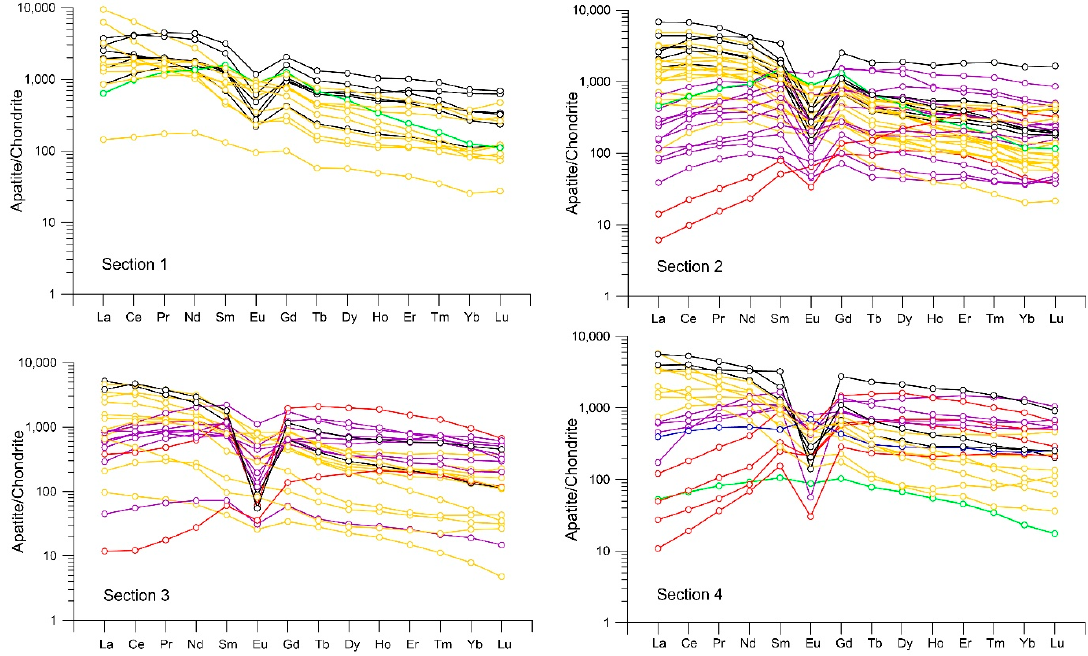
Figure 3. The chondrite-normalized rare earth element (REE) patterns of detrital apatites in the four sections of Core S3 from the South Okinawa Trench (SOT). The chondrite REE values are from Reference [73]. Note: REE patterns with deep yellow color, black color, purple, and red color indicate Population 1, Population 2, Population 3, and Population 4, respectively.